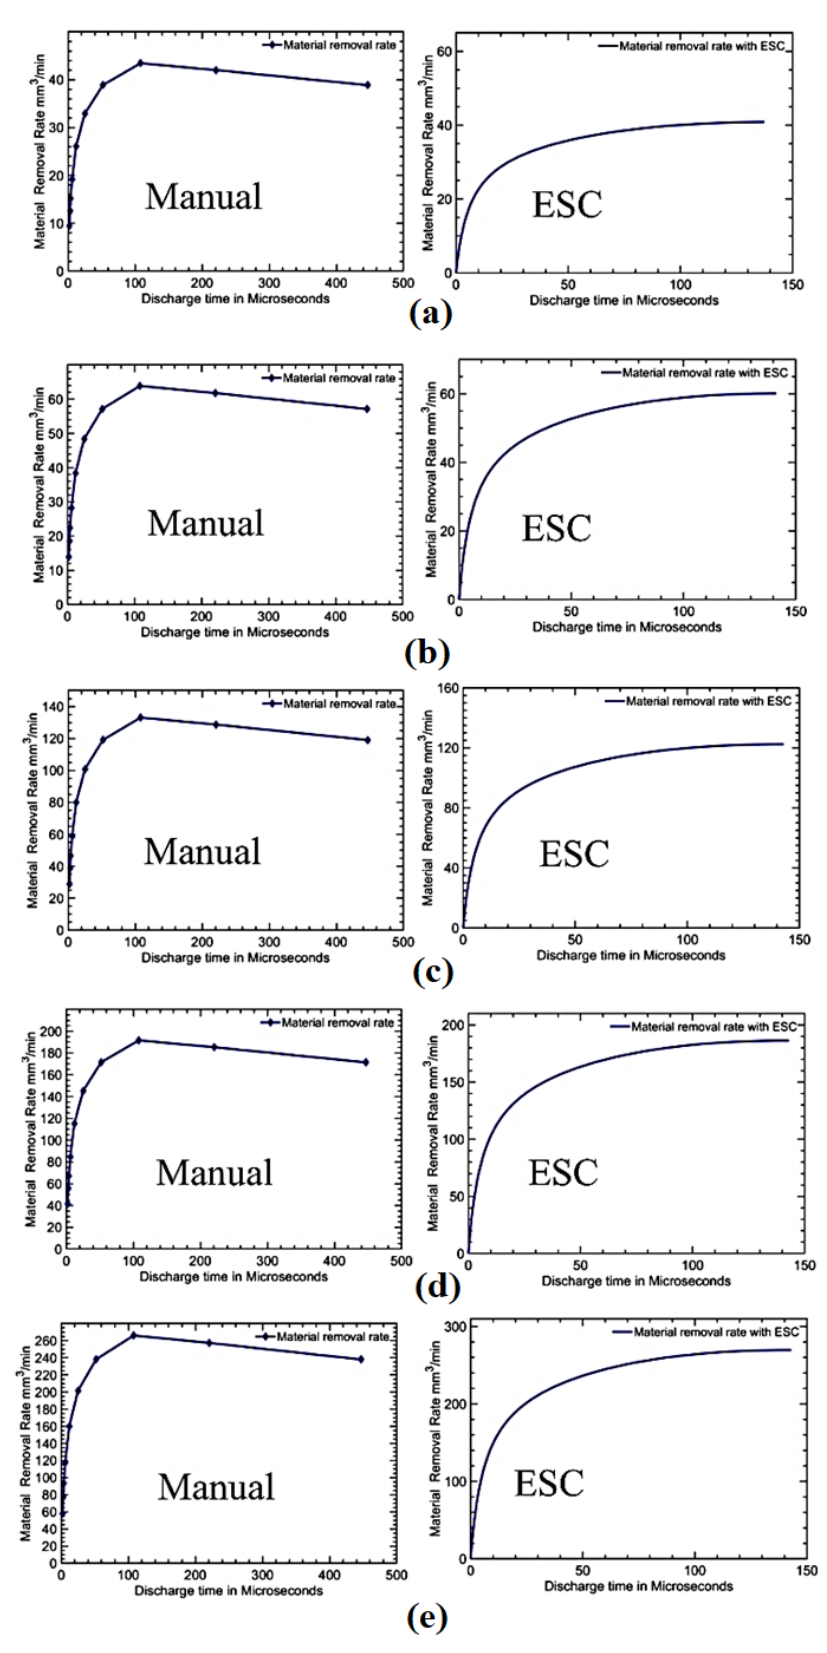
Figure 10. Comparison of discrete manual searching ( left ) and extremum-seeking optimal searching ( right ) for gap currents ( a ) 8.5 A, ( b ) 12.5 A, ( c ) 25 A, ( d ) 36 A, and ( e ) 50 A.